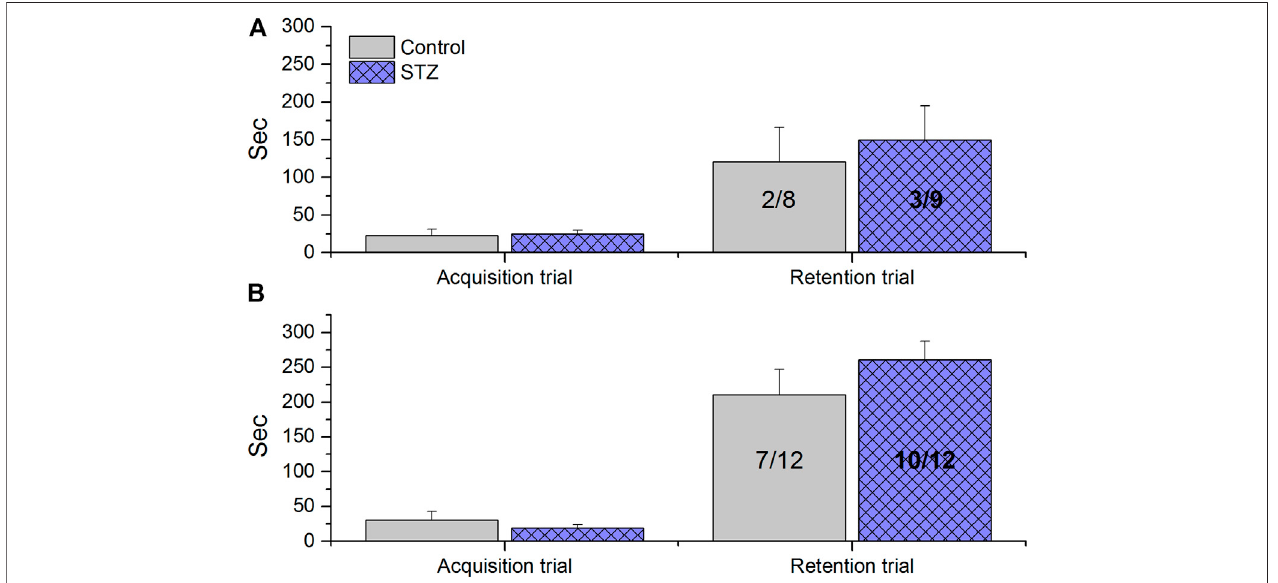
FIGURE3| PassiveAvoidanceLearning resultsofratstreatedwithicv.streptozotocin(STZ)orcitrate buffer(control). Columns showmeans ± SEMvaluesofentry latencies,numbersinsidethecolumnsindicatethenotentered/totalnumberofanimals. (A) Resultsofexperiment1(EXP1),whentheanimalsreceived2 × 1.5 mg/kgicv. STZ 11 weeks before the test. No signi fi cant difference was observed between control and STZ-treated animals (unpairedt-test acquisition trial: t (15) (cid:2) − 0.23, ns; unpaired t -test retention trial: t (15) (cid:2) − 0.45, ns; Fischer exact p, two tailed test p (cid:2) 1.0, ns). (B) Results of experiment 2 (EXP2), when the animals received 3 × 1.5 mg/kg icv. STZ 6 weeks before the test. No signi fi cant difference was observed between control and STZ-treated animals (unpaired t -test acquisition trial: t (22) (cid:2) 0.85, ns; unpaired t -test retention trial: t (22) (cid:2) − 1.10, ns; Fischer exact two tailed test p (cid:2) 3707).